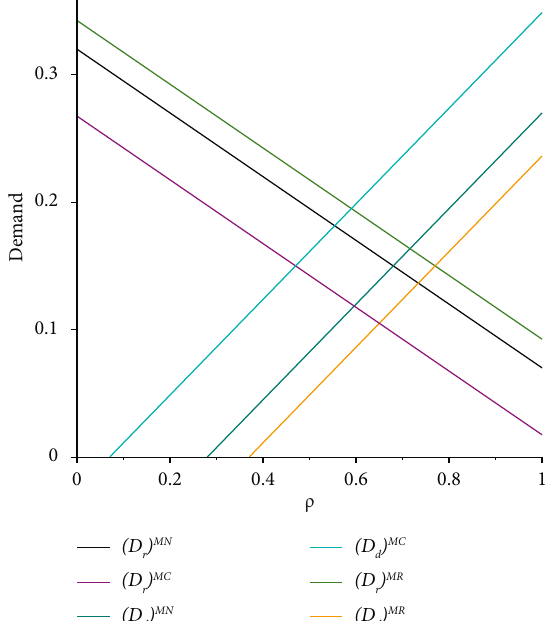
Figure 10: Effect of ρ on optimal